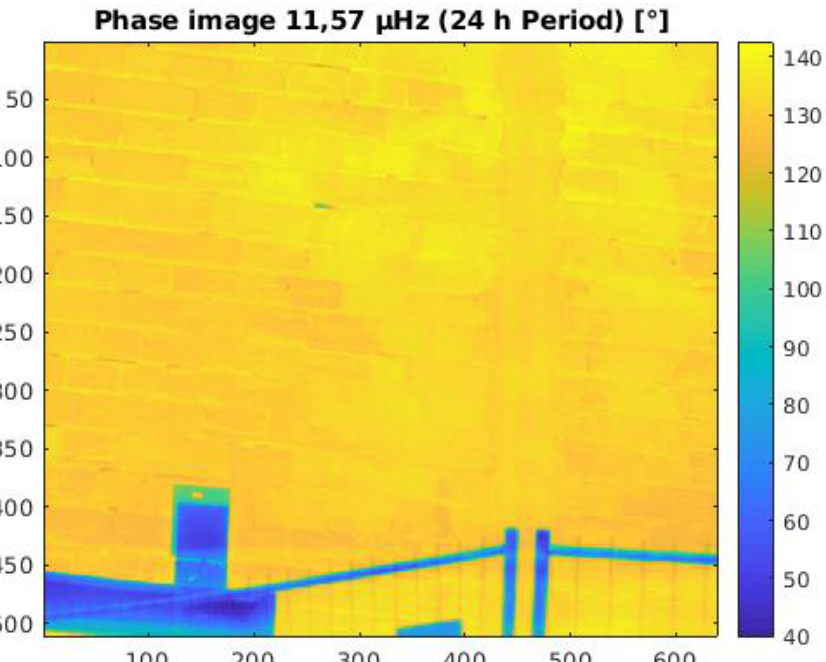
Figure 11. Phase image of the fundamental 24 h period. This image depicts the 24 h phase information every pixel over the 96 h measurement period 𝑎𝑟𝑐𝑡𝑎𝑛 (ℑ𝑚{𝑆 𝑥𝑦 }/ℜ𝑒{𝑆 𝑥𝑦 }) . Note that 90° phase would correlate to an angle of a sine wave, which has its origin at the time of the experiment start (8:00) and maximum 6 h later at 14:00. Note that higher angle values mean ‘earlier’ thermal responses to the input. If the phase angle value is lower, that corresponds to a ‘slower’ response to the periodic heat input.